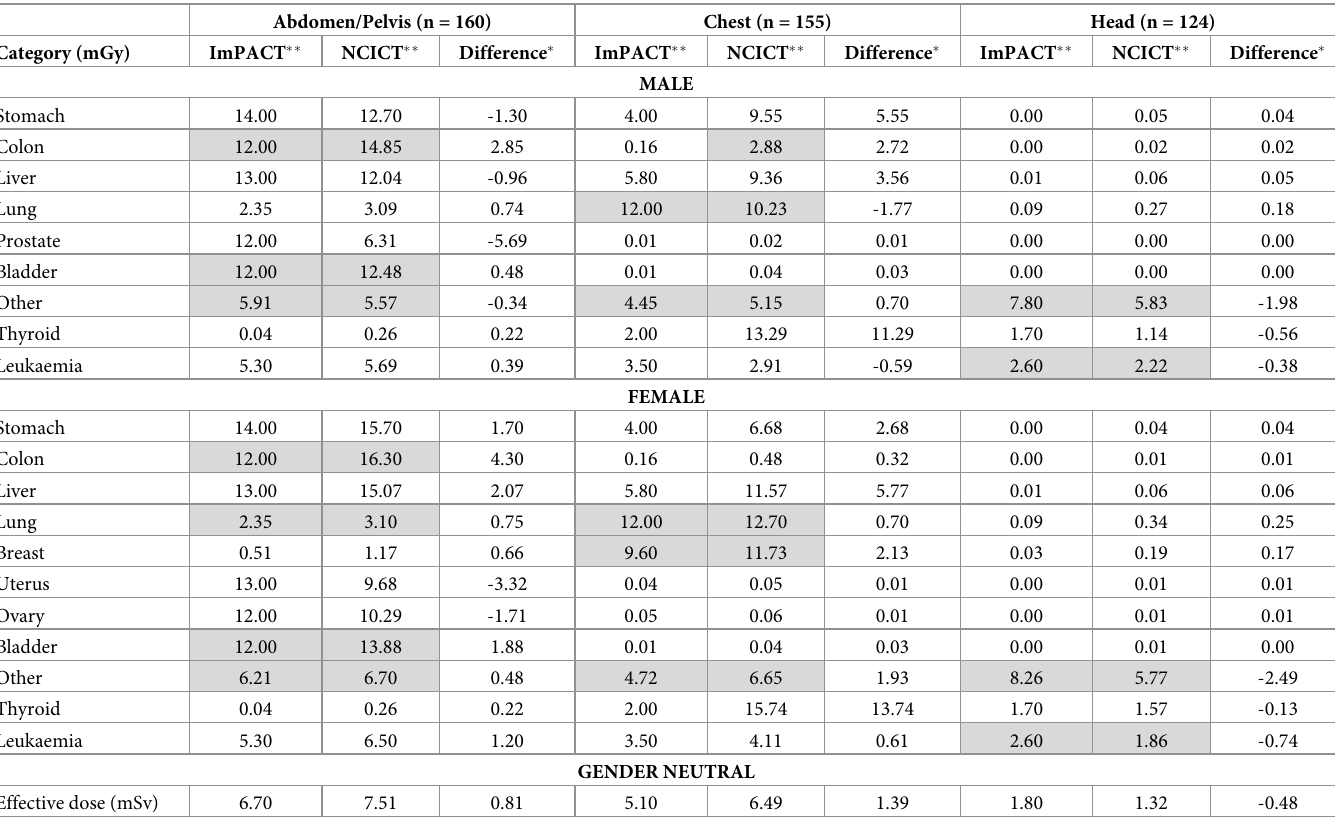
Table 1. Median of the organ equivalent dose for each protocol by BEIR VII category (male and female) and effective dose (gender neutral).